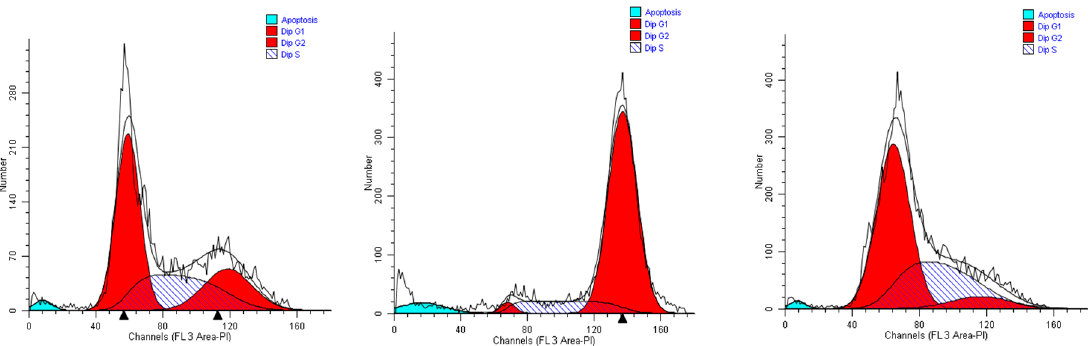
Figure 5. Representative cell cycle profiles of untreated MCF-7 cells (controls, left ), and cells incubated in media containing 0.15% ( v / v ) of extracts #46 ( middle ) and #57 ( right ).